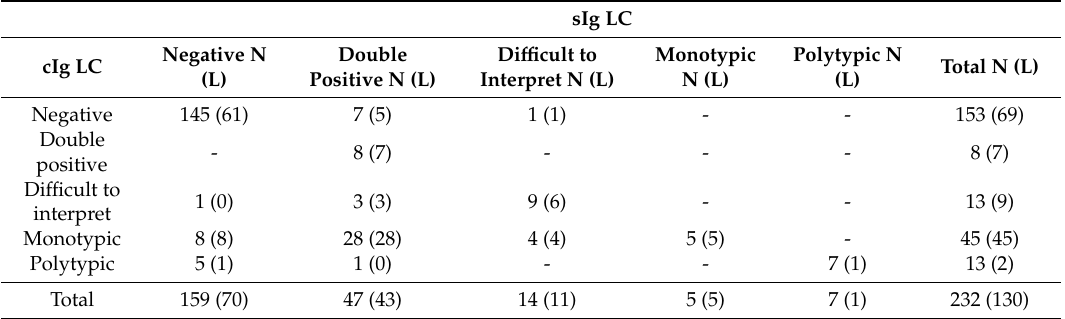
Table 2. Expression of cIg LC in groups with specific expression of sIg LC in FNA of lymph nodes.